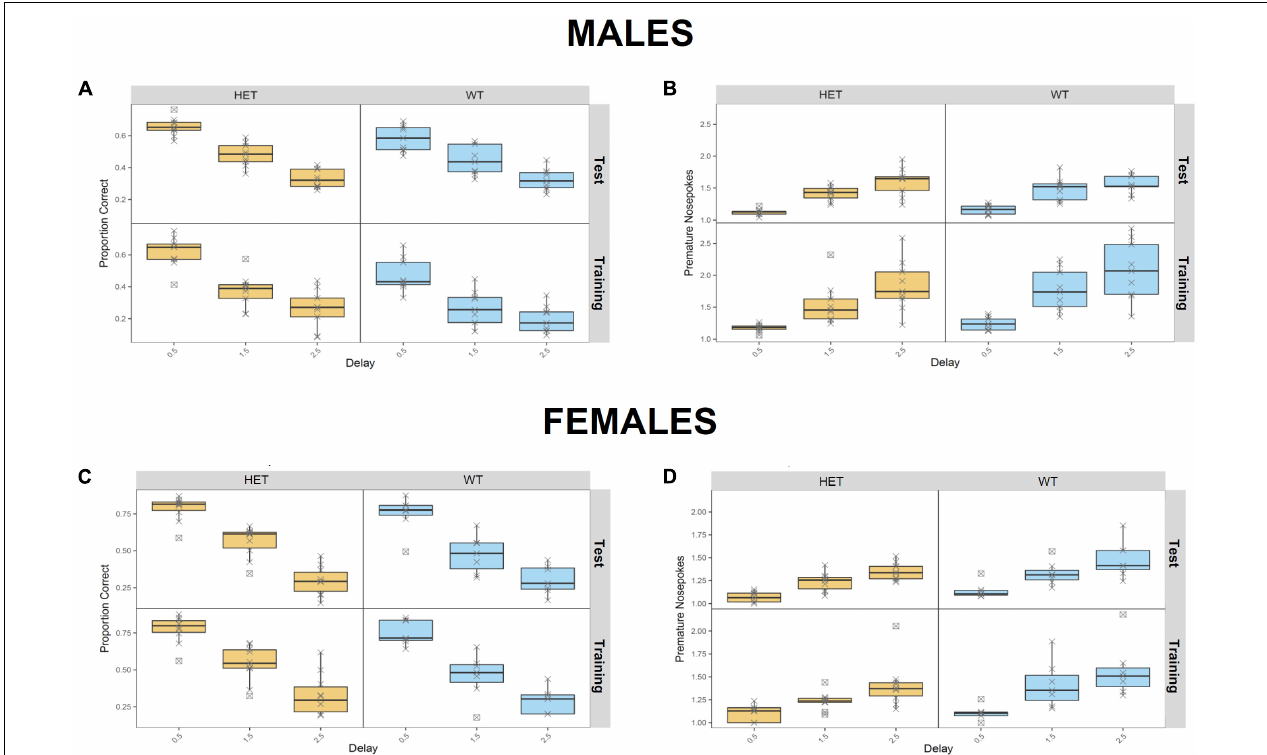
FIGURE 5 | Assessment of motor impulvisity in St3gal3 HET mice with the reaction time task. (A,C) Mean proportion of correct responses (depending on the delay between first and second nosepoke) made by males (A) and females (C) in the training and test phases. (B,D) Average number of premature nosepokes made by males (B) and females (D) in the training and test phases, depending on the delay between first and second nosepoke. A strongly significant effect of the delay on premature responses and correct responses was observed in both cohorts ( p < 1e-08). In males, a genotype effect in the proportion of correct responses (A) was also detected in the test ( F 1 , 47 = 5.16, p = 0.02774) and training ( F 1 , 47 = 9.475, p = 0.003471) phases, but no effects in the number of premature responses were seen. In females, we observed a significant effect of the genotype x delay interaction in the proportion of correct responses ( F 2 , 44 = 4.624, p = 0.01504), as well as a significant genotype effect in the number of premature responses during the test phase ( F 1 , 15 = 5.236, p = 0.03706). Data were analyzed with FlowR using a generalised linear binomial modelling with random error estimation ( F -test) to prevent significance overestimation due to overdispersion. Data are shown as mean ±